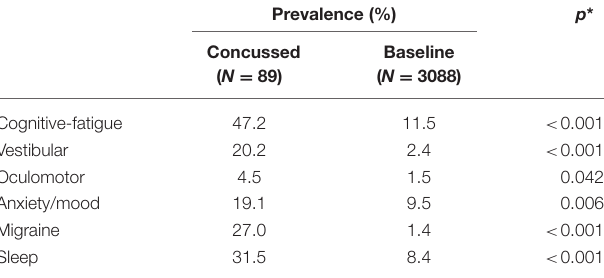
TABLE 1 | Prevalence of moderate-to-severe symptom